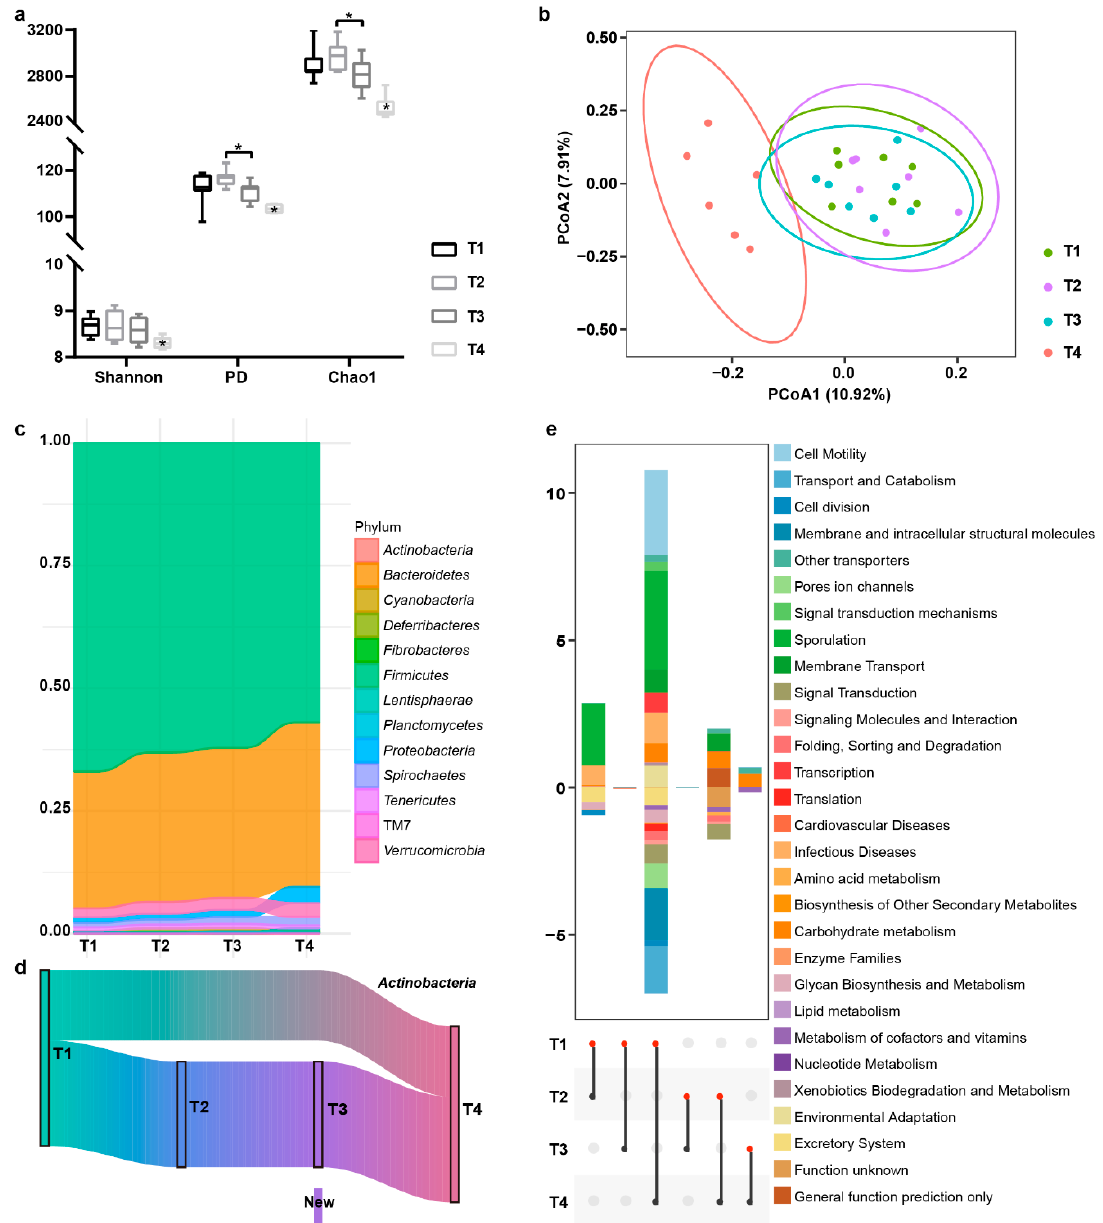
Figure 4. The correlation between intestinal microbial communities and probiotics feeding time. ( a ) Bacterial alpha diversity based on Shannon diversity, PD (Phylogenetic diversity), and Chao1 index. * on T4 box indicates the significant difference of T4 compared with other 3 groups ( p < 0.05). ( b ) PCoA plot for the Bray Curtis dissimilarity of fecal microbiota from the 4 groups. Each dot represented the composition of the microbiota of each sample. Samples were grouped by colors as label showed. ( c ) Stream graph indicated the bacterial taxonomic composition and the change of relative abundance at phylum level from T1 to T4. Phyla Firmicutes and Bacteroidetes dominated the core microbiome in Tan breed sheep, phyla Verrucomicrobia and Proteobacteria followed. ( d ) OTUs that were shared in at least 50% of the population, at each sampling time, using Sankey plots, in Actinobacteria , which contained bifidobacteria . The heights of the black rectangles showed the relative number of OTUs at each sampling time, and the separated rectangle showed the emerging OTUs at T3 simply. ( e ) Stacked bar chart represented pathways ( n = 29) with significant differences between 2 groups (bottom-colored spots). The upper x axis KEGG pathways displayed pathways with a greater number of OTUs in the red dot group than that in the black dot group, while that in the lower x axis was opposite. The height of each colored bar indicated the difference between 2 groups.